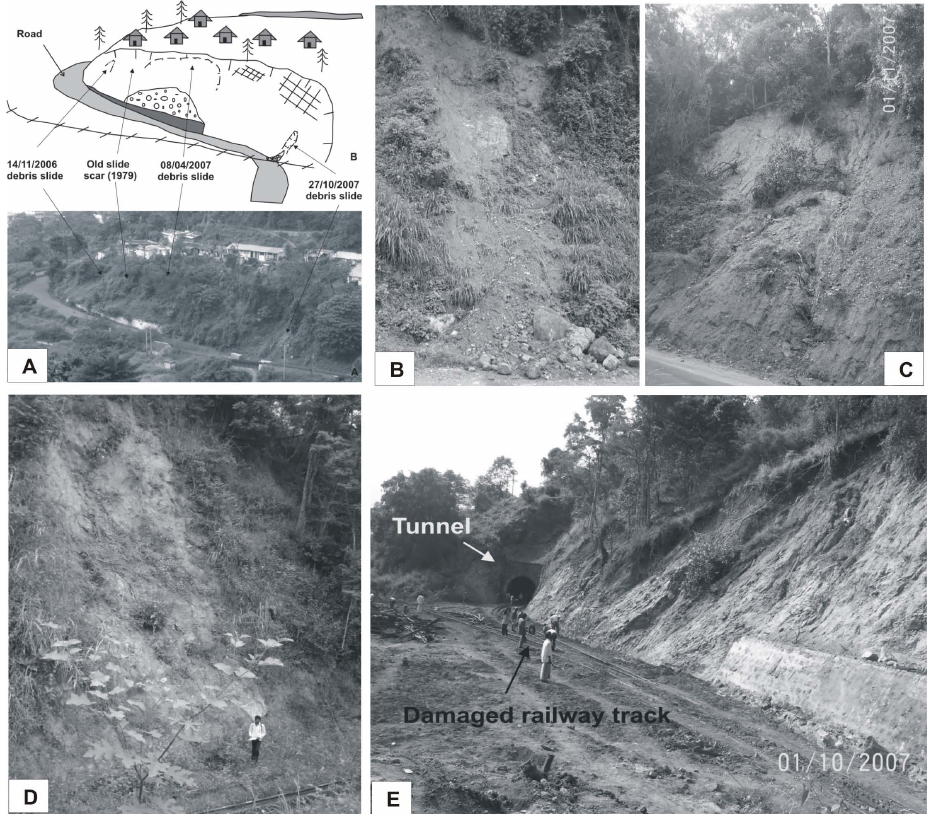
Fig. 2. Landslides on cut slopes along the road (A–C) and the railway line (D–E) . Black arrow indicates the position of the railway track which was completely damaged (E)